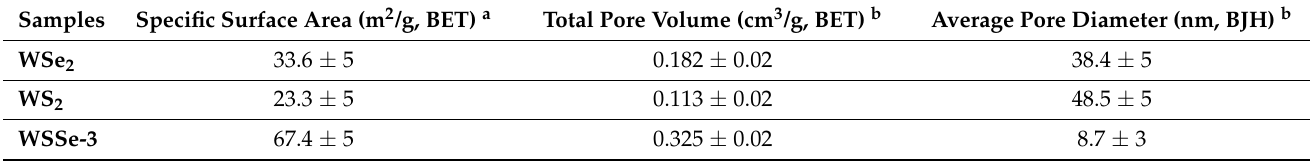
Table 1. The physical adsorption parameters of the photocatalysts of WS 2 , WSe 2 , and WSSe-3 were measured three